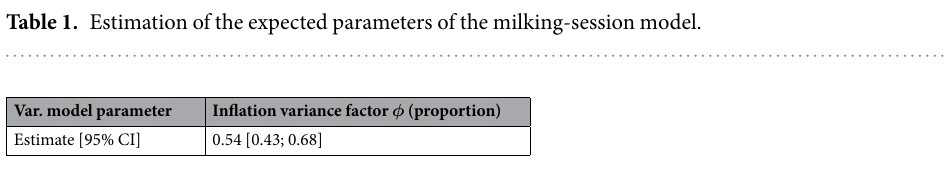
Table 2. Estimation of the variance parameters of the milking-session model.